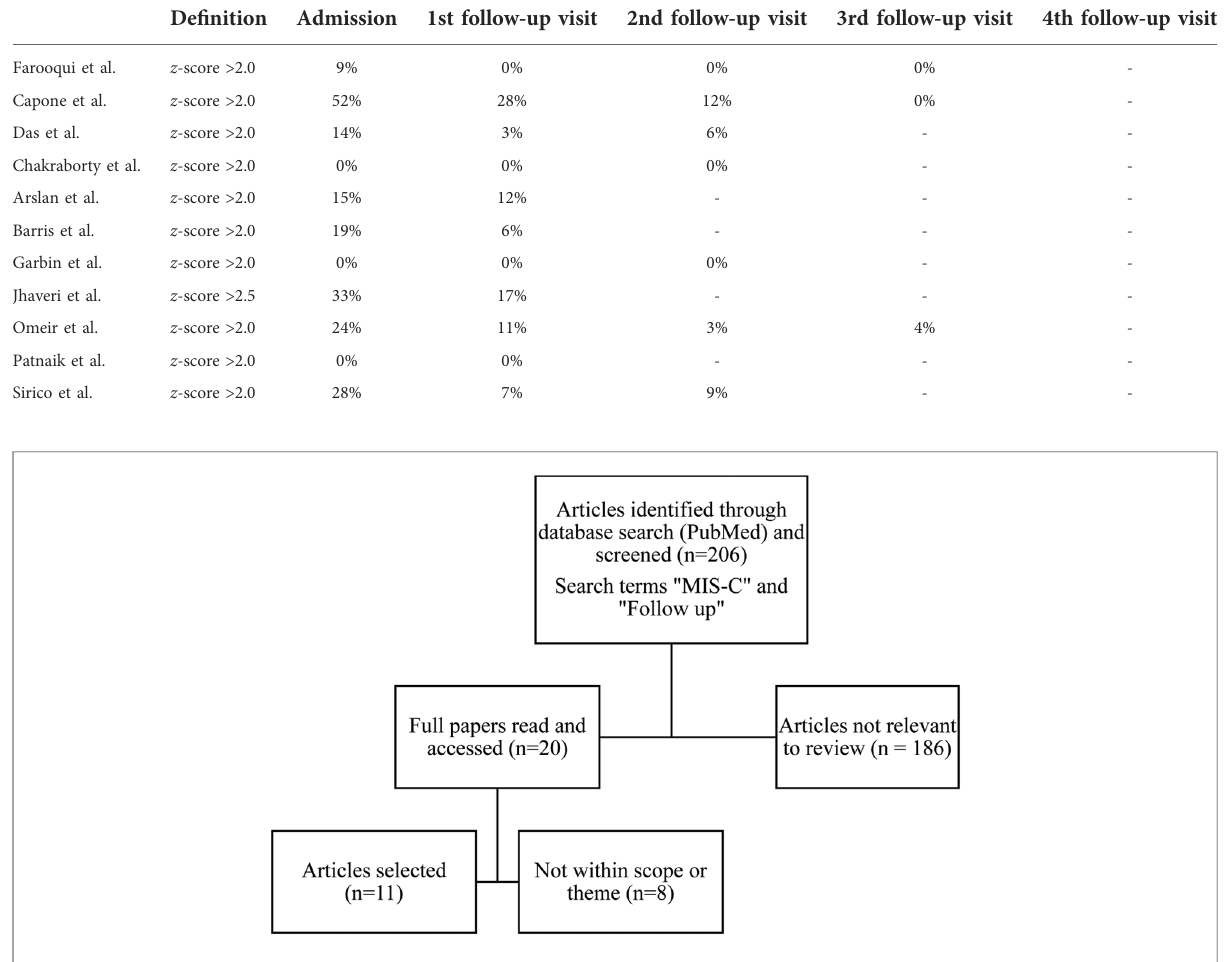
TABLE 3 Coronary artery dilation/aneurysm data.